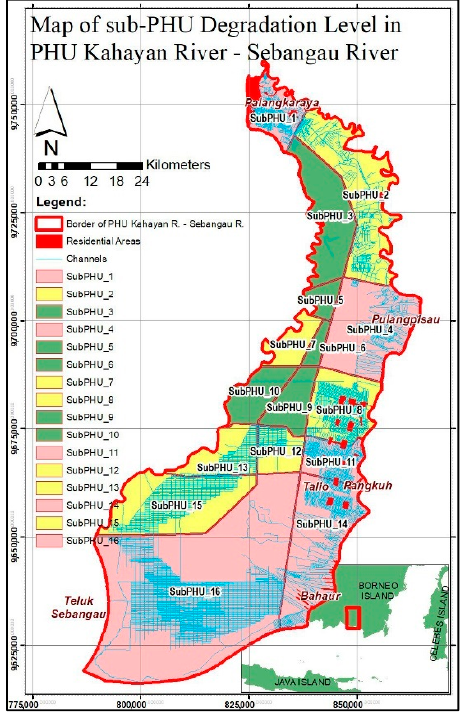
Figure 11. The map of the sub-PHU degradation levels to determine the most prioritized areas (in UTM zone 49 S coordinate system). UTM zone 49 S coordinate Table 8. The rank of sub-PHUs based on 11 criteria to determine the most prioritized areas in the